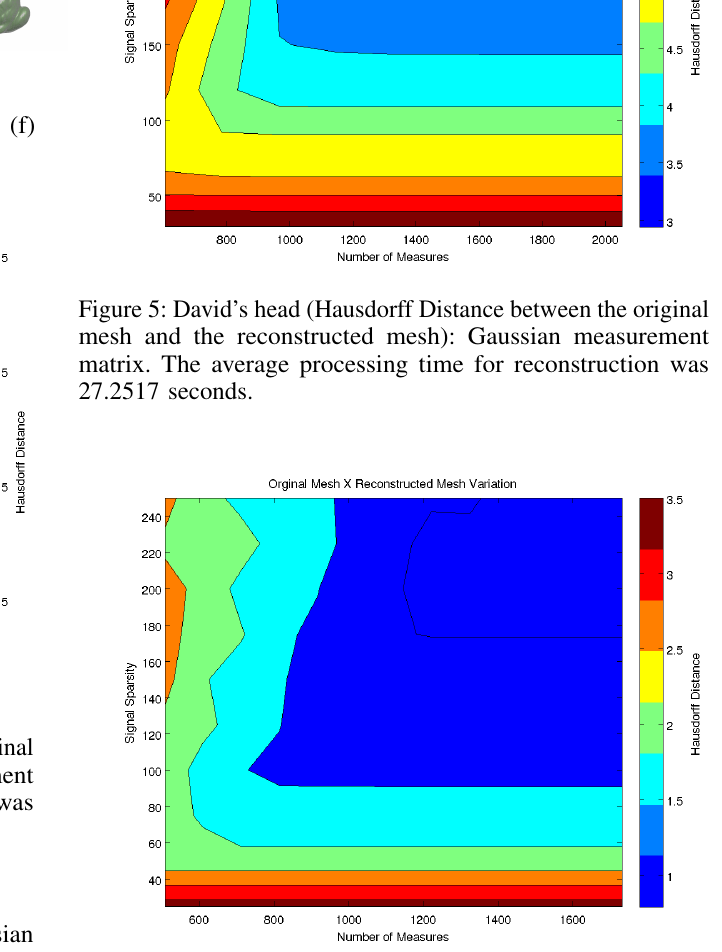
Figure 6: Fandisk (Hausdorff Distance between the original mesh and the reconstructed mesh): Noiselet measurement matrix. The average processing time for reconstruction was 42.7562